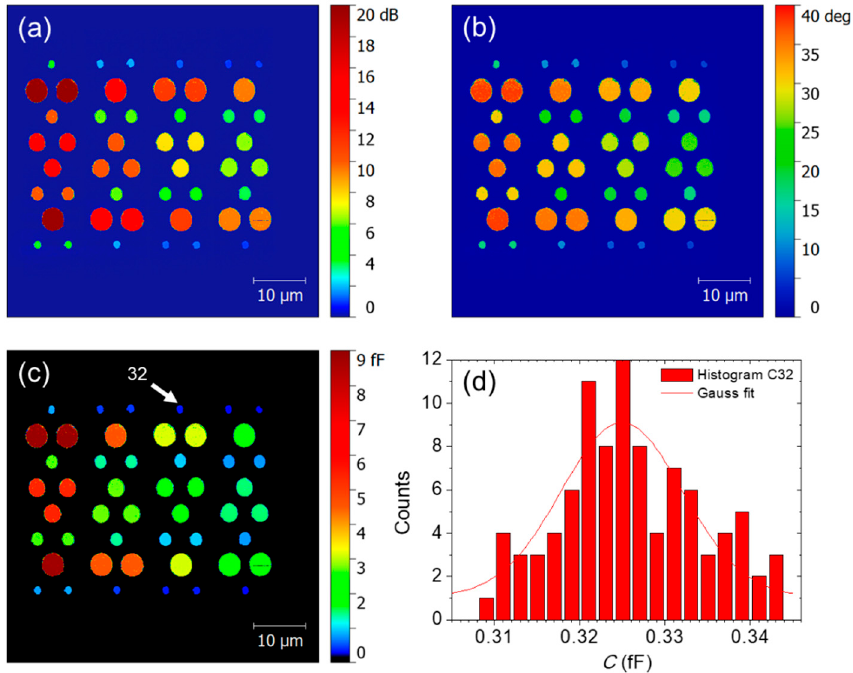
Figure 3. ( a ) S 11 magnitude, ( b ) S 11 phase, and ( c ) capacitance map measured on A61F08 pattern. ( d ) Histogram of capacitance map recorded for the pad 32. The maximum count occurs for a capacitance value which agrees well with the mean value of the Gaussian distribution within the standard deviation of 7 aF.